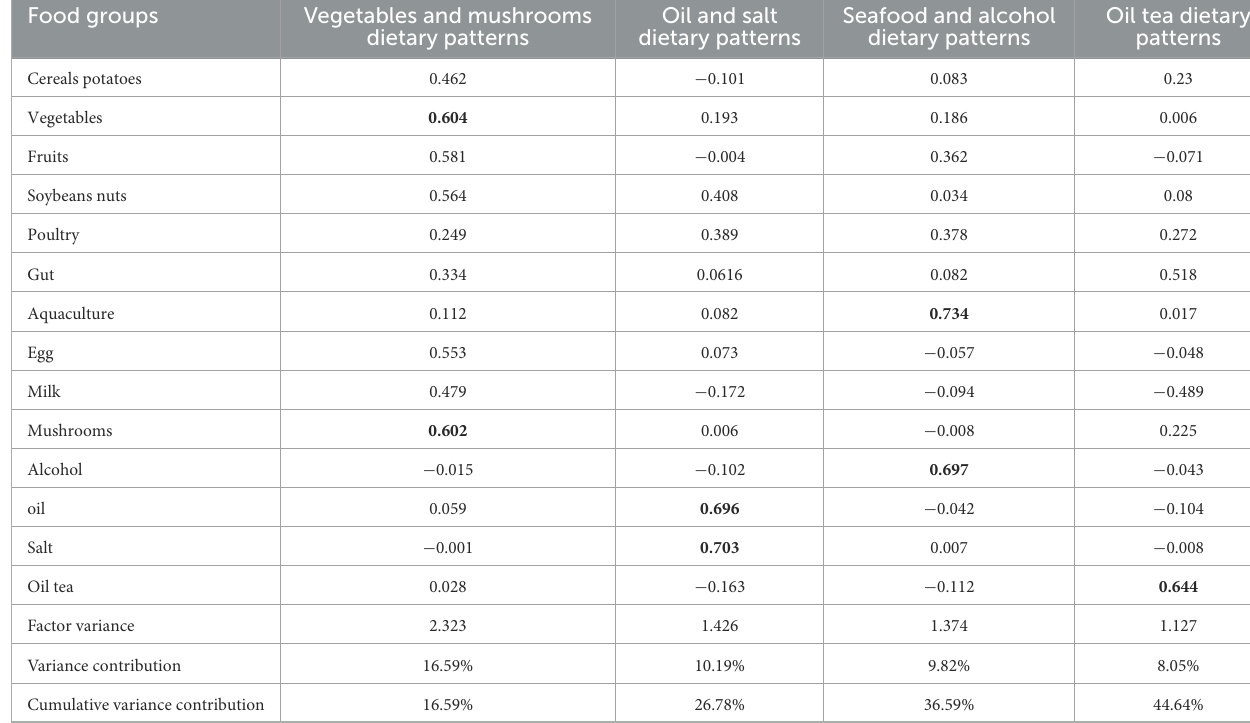
TABLE 5 Factor loadings of four principal components of 14 food groups extracted from principal component analysis (PCA) of eating frequency data of 884 adults aged 60 years or older. Food groups Vegetables and mushrooms